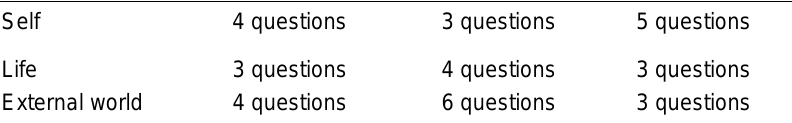
Overview of the Frame from which the 35 Questions were